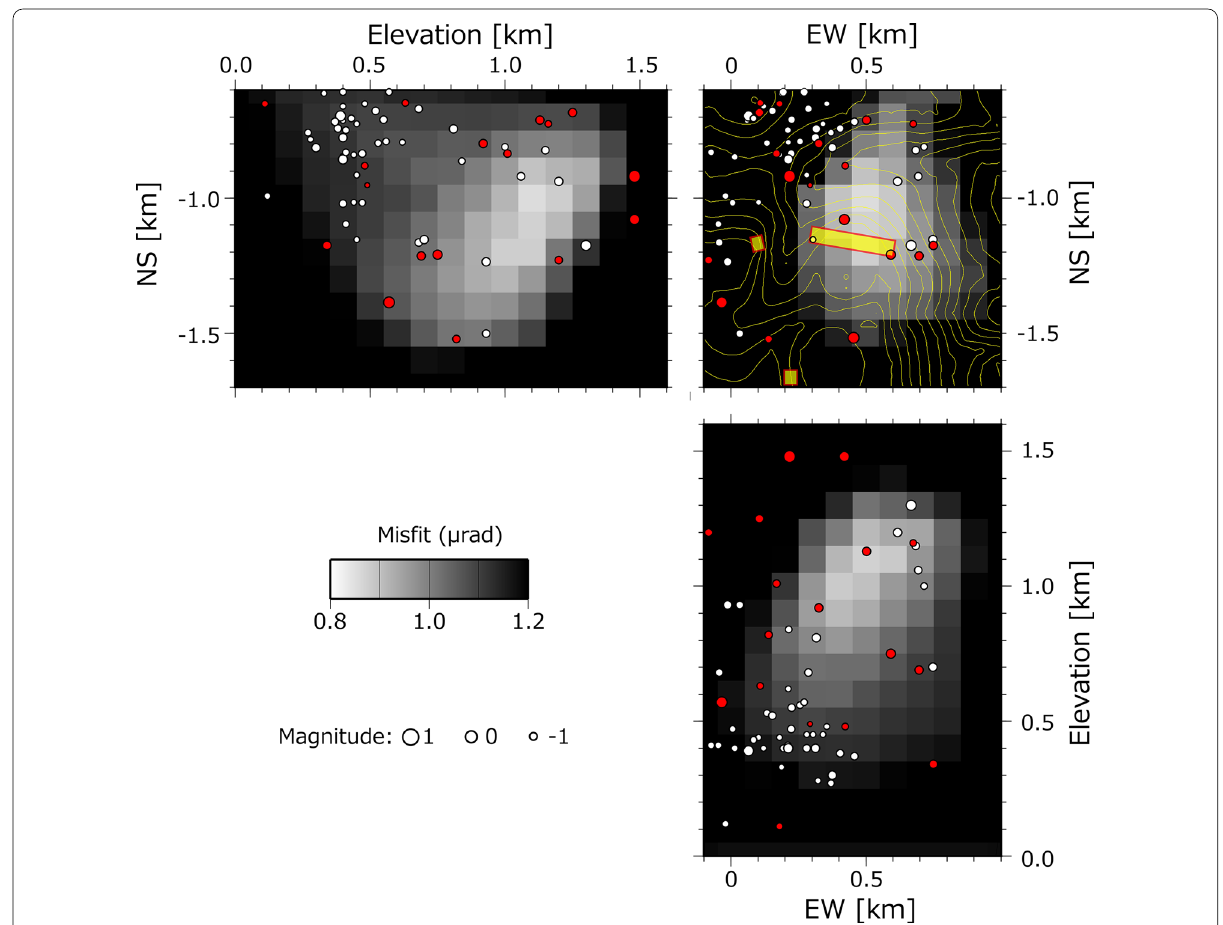
Fig. 6 Spatial distribution of misfit values in horizontal and vertical cross-sections at intervals of 100 m. For each panel, we fixed Z (horizontal cross-section), X (N–S cross-section), and Y (E–W cross-section) to optimum values of 1100 m asl, 36.629° (latitude), and 135.540° (longitude), respectively. Using the same method as in Section “Modeling”, we searched for the best-fit parameters L, A, D, U, and location (X and Y for horizontal cross-section, Y and Z for N–S cross-section, and X and Z for (E–W cross-section) within the range described in Section “Modeling”. Yellow lines are topographic contours at intervals of 20 m. Yellow squares indicate the locations of craters formed during the 2018 eruption. White and red circles represent hypocenters determined by the KSVO for the periods from 1 January 2016 to 22 January 2018 (before the eruption) and from 23 January to 22 April 2018 (after the eruption),